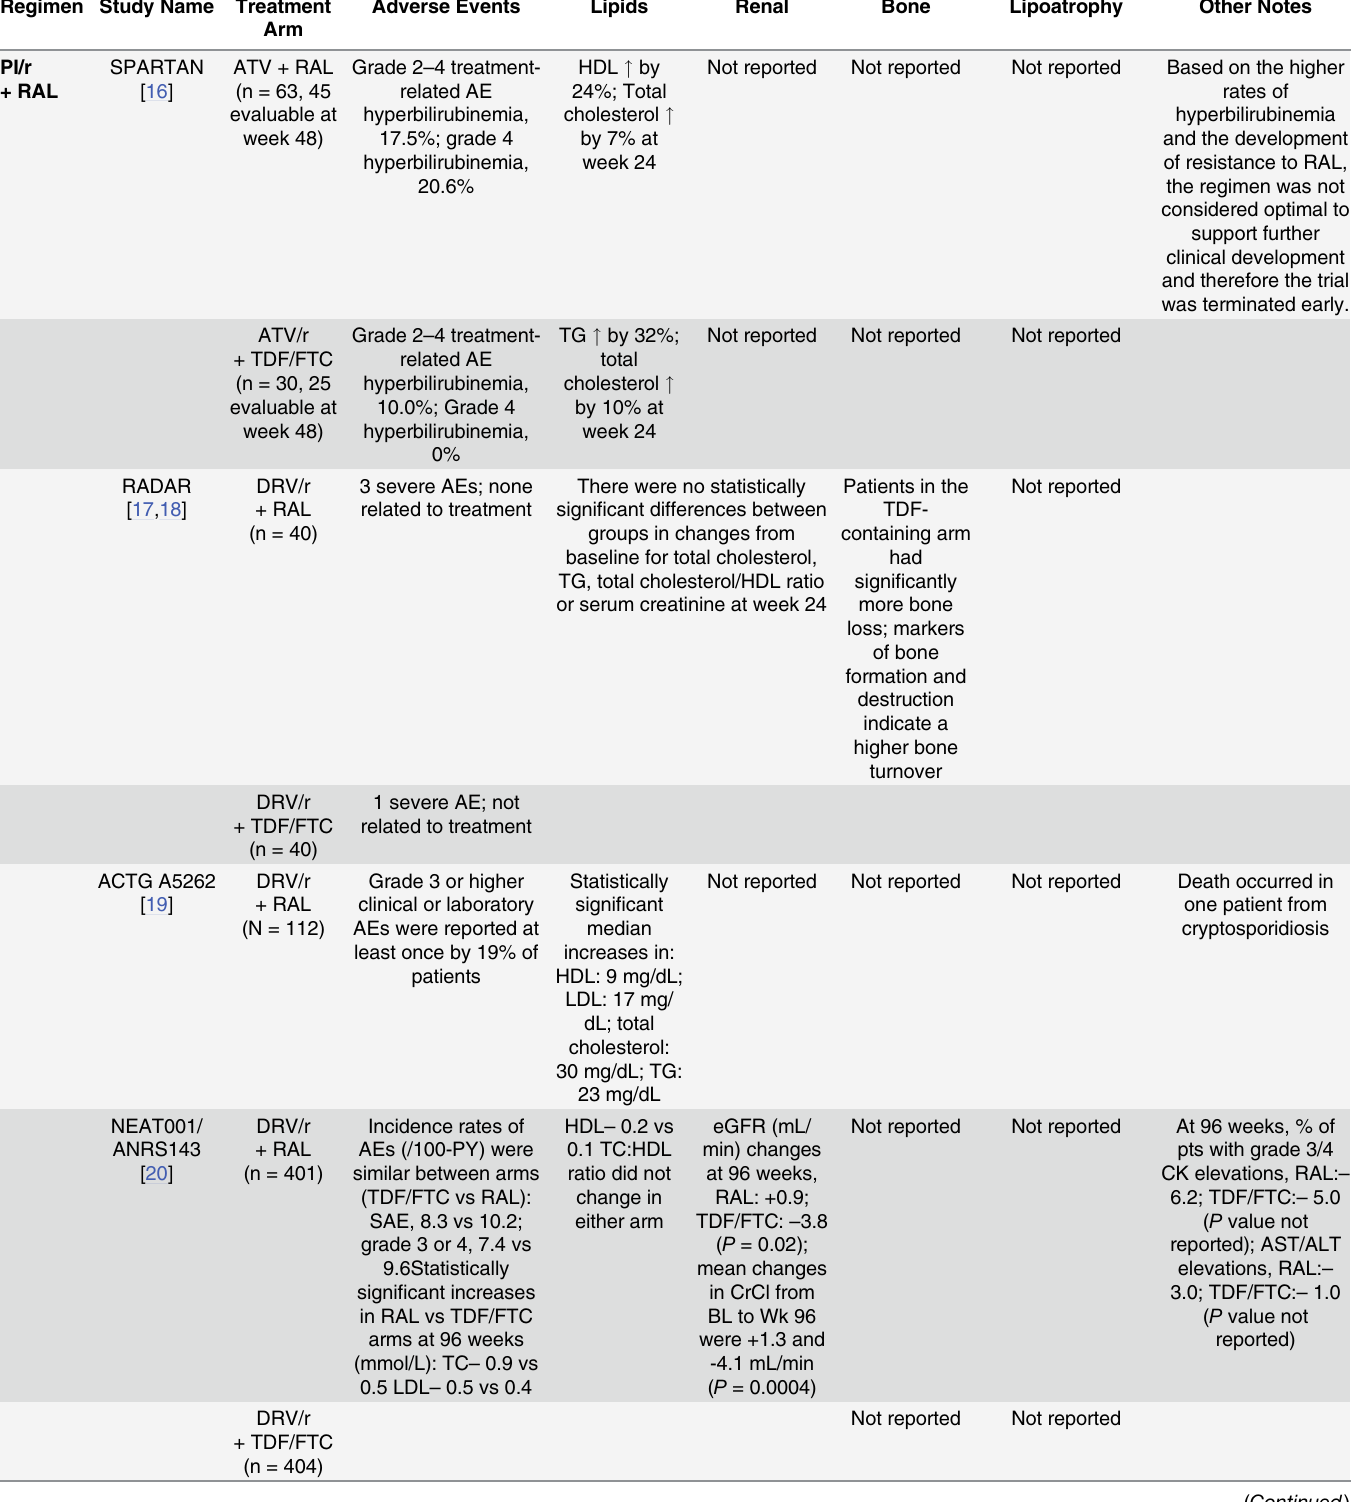
Table 3. Results of key secondary endpoints from identified trials among ARV-naive